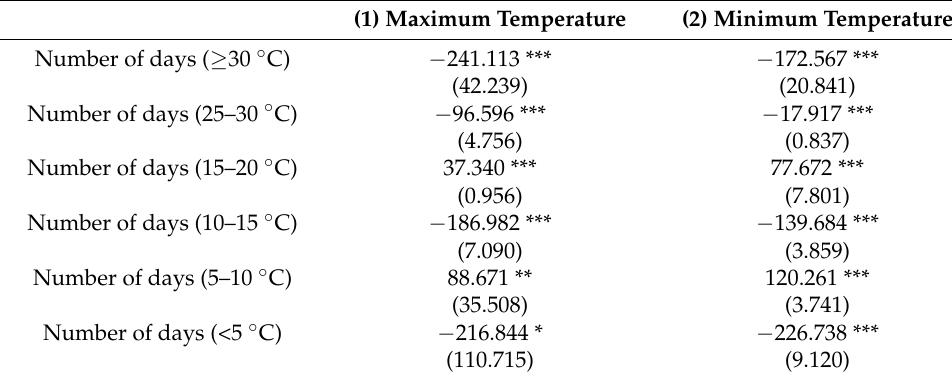
Table 6. Robustness checks: alternative temperature